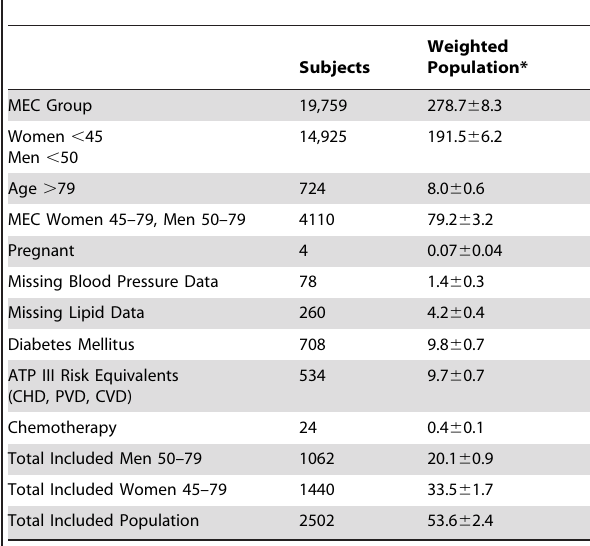
Table 2. Inclusions/Exclusions from 1999–2002 NHANES